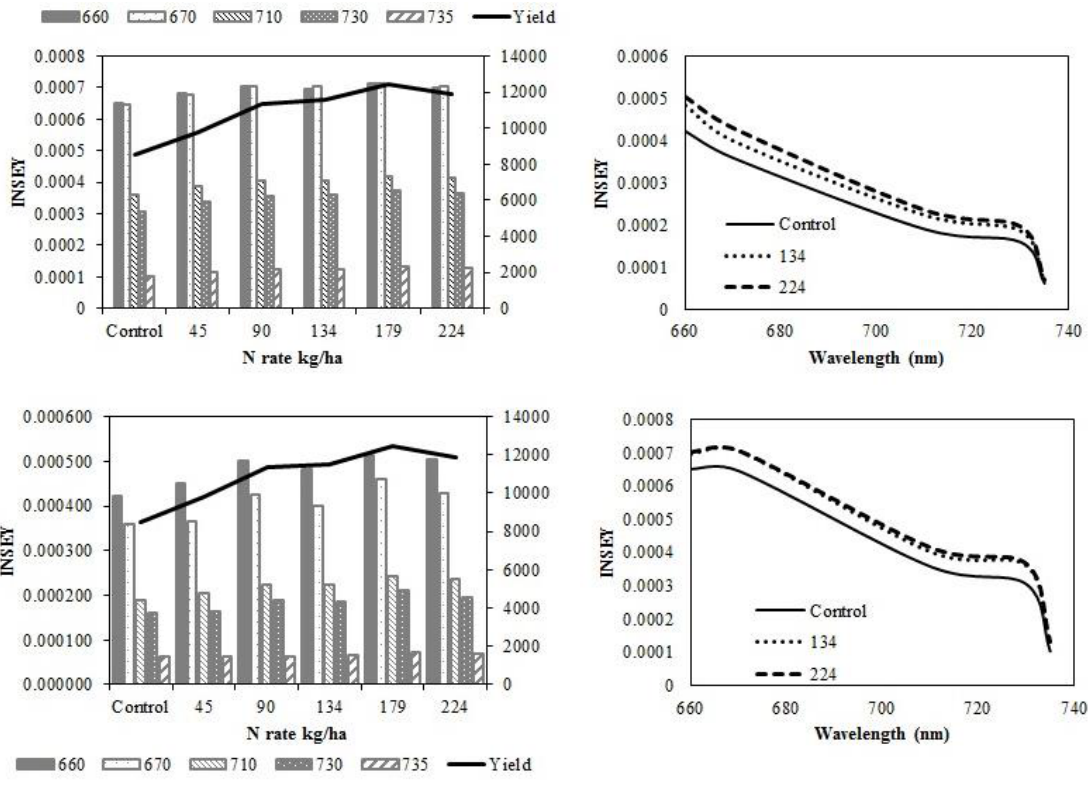
Figure 3. Variation of INSEY for corn at medium-textured conventional-till sites calculated from CC active-sensor spectra (670 nm and 730 nm) and GS spectra (660 nm, 710 nm and 735 nm) with N rate compared to yield variation with N rate at V6 (upper left) and V12 (lower left) . Trend for INSEY at three N rates (control, 134 kg∙ha −1 and 224 kg∙ha −1 ) over the five wavelengths represented as a continuous spectrum is displayed at V6 (upper right) and at V12 (lower right)